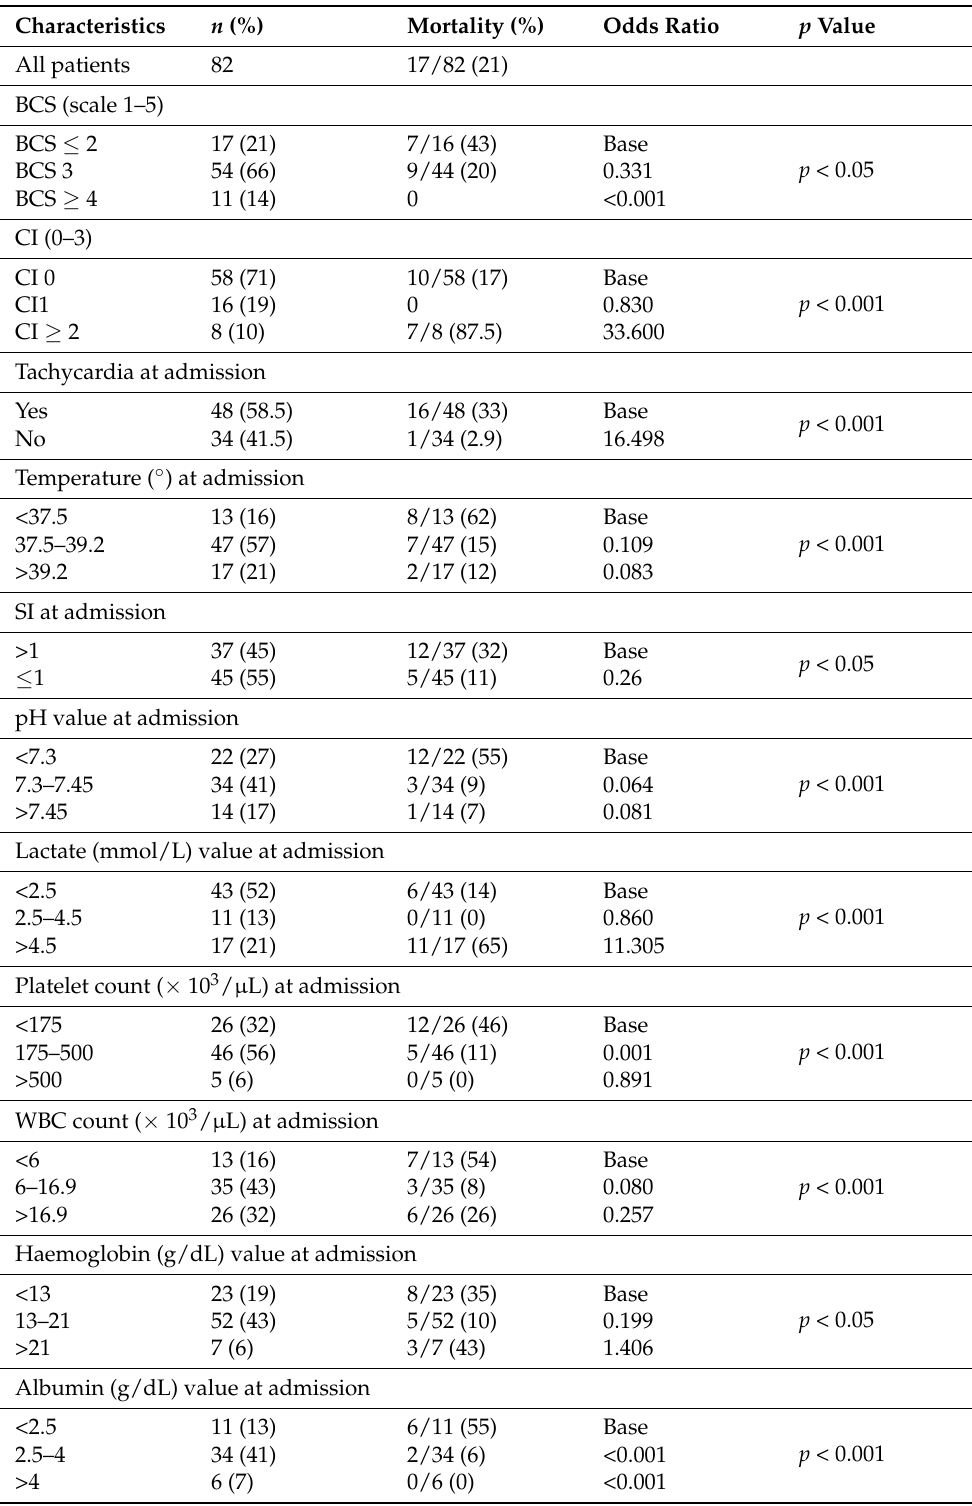
Table 5. Variables correlated with death in the multiple logistic regression